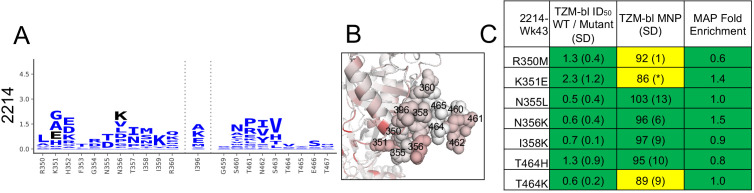
A, B, and C as in Figure 4, but for the single sera with limited targeting of the C3/V5 epitope.